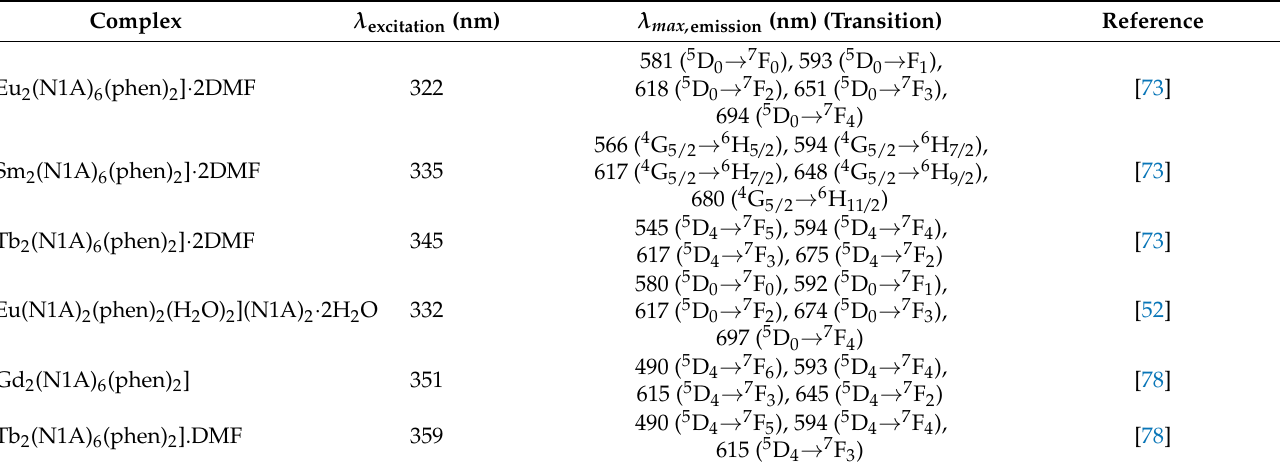
Table 5. Luminescence data for reported